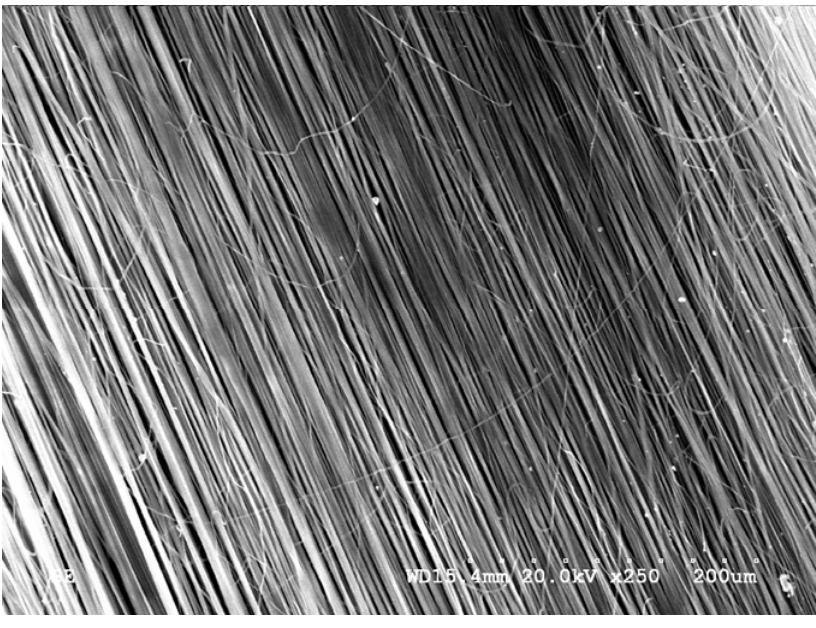
Figure 3. SEM image of electrospun poly( -lactide) (PLA) fibers using a rotating disk. A L mixture of DCM/DMF (4/1, wt/wt) was used to dissolve PLA prior to electrospinning. The concentration of PLA solution was 8 wt%. Fibers were electrospun under the conditions of flow rate: 0.8 mL/h, electric field strength: 29 kV and disk rotation speed: 2,500